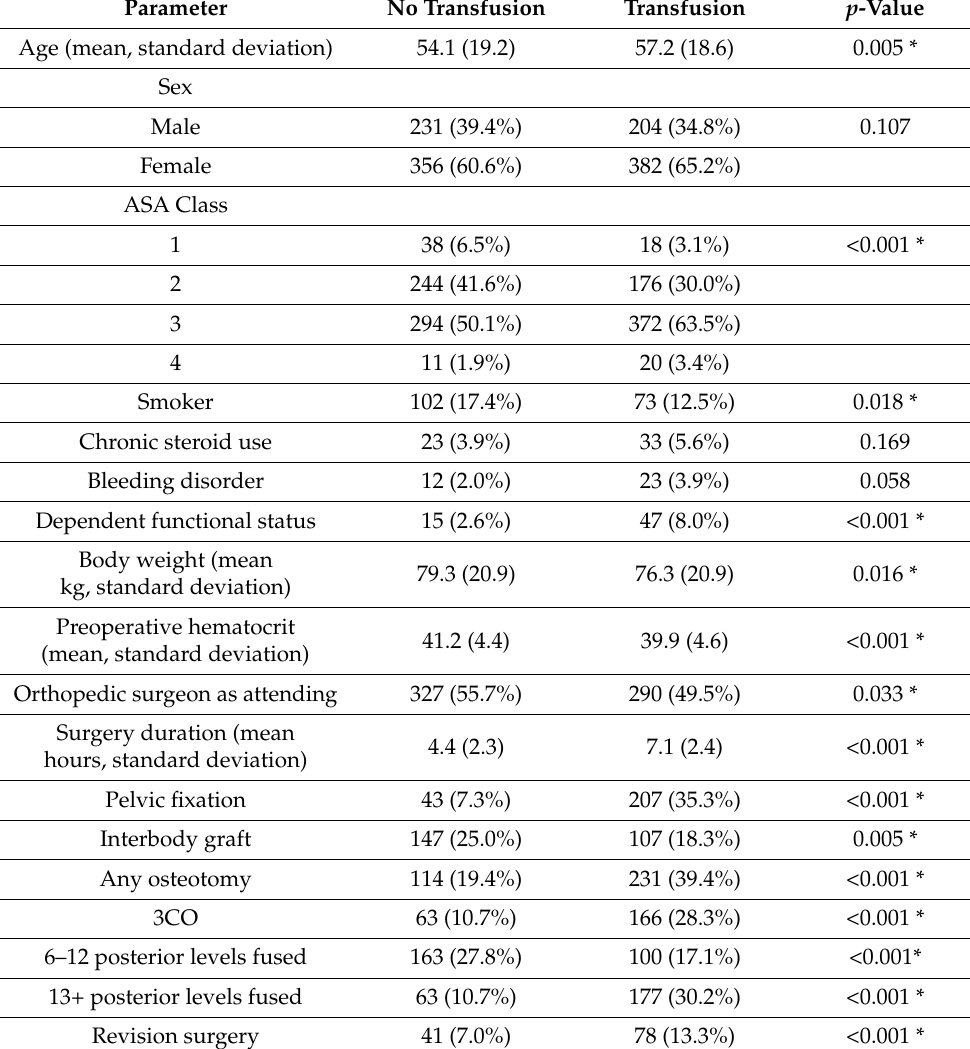
Table 2. Baseline and operative characteristics of all patients stratified by transfusion